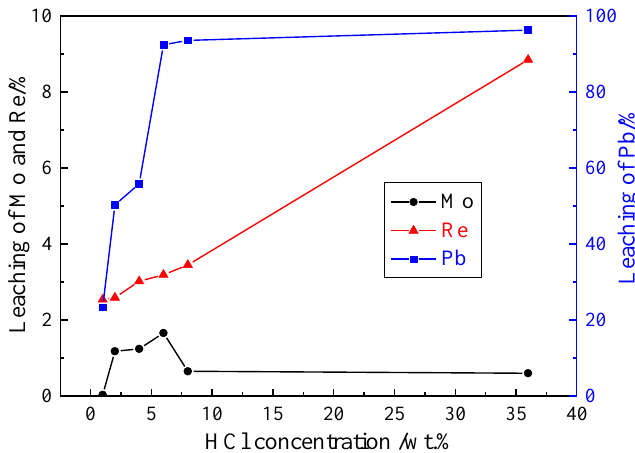
Figure 3. Effect of HCl concentration on the leaching of Mo, Re and Pb.